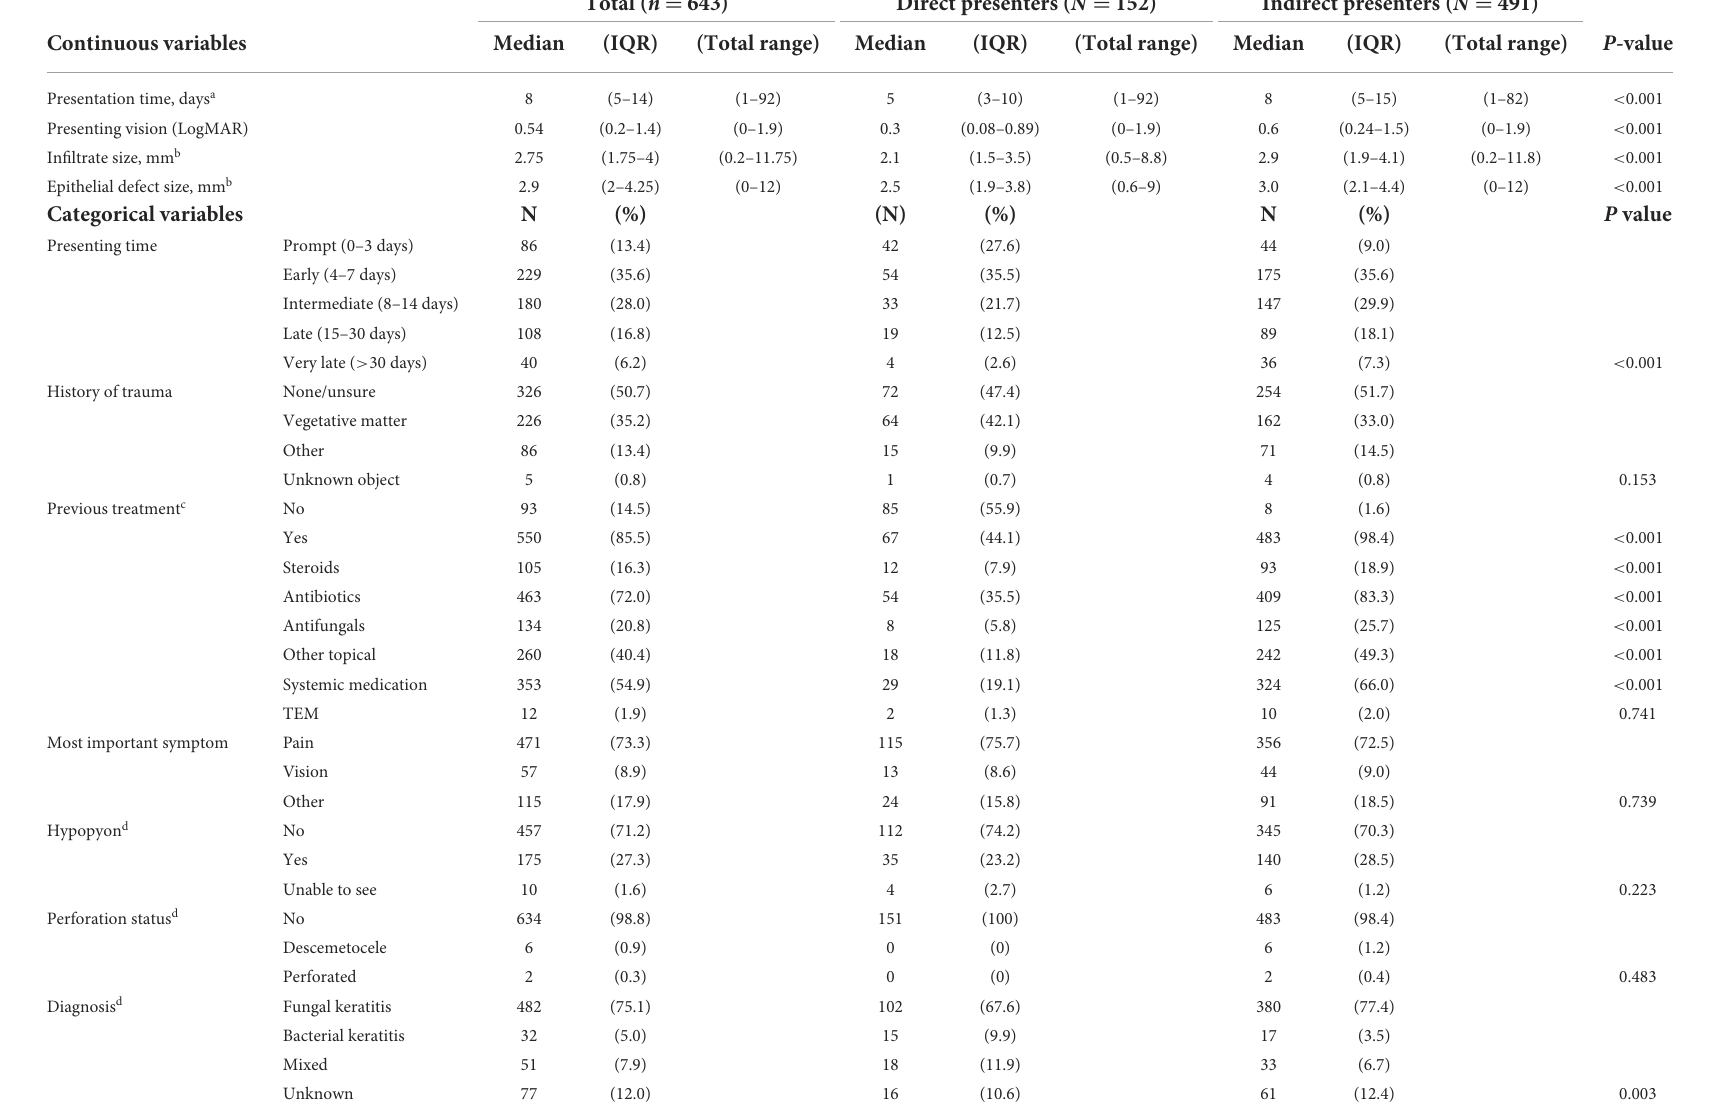
TABLE 2 Clinical history and clinical signs of direct vs. indirect presenters ( n =